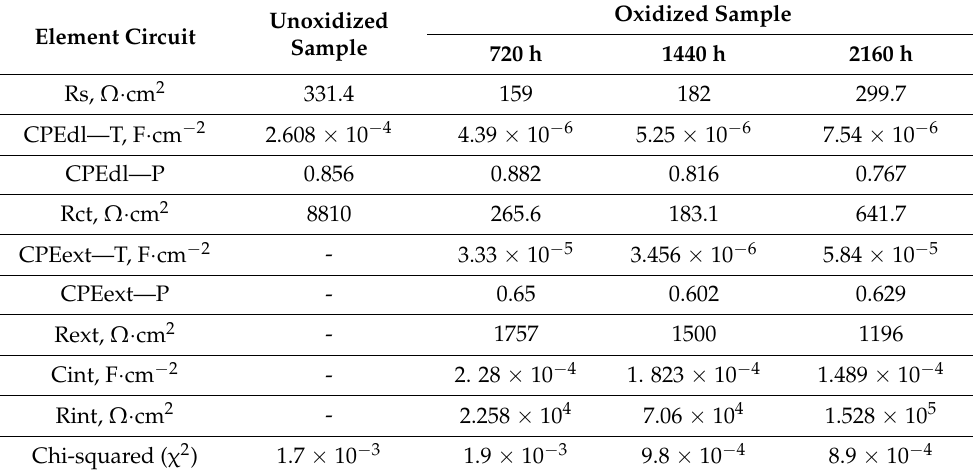
Table 4. The values of equivalent electrical circuits elements for unoxidized and oxidized samples for different periods in water at 550 °C and 250 atm.